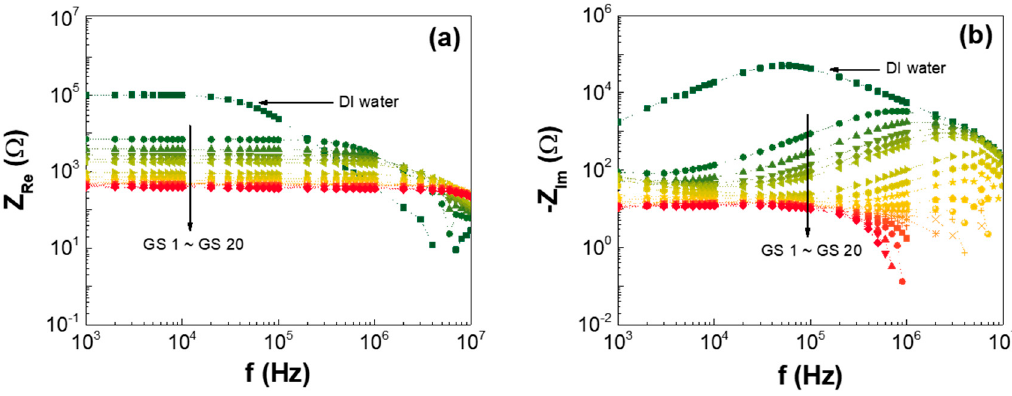
Figure 2. Frequency response of the ( a ) real and ( b ) imaginary portions of the GS impedances at different GSes.